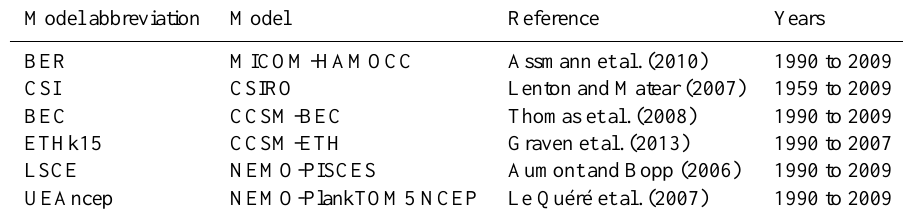
Table 2. Details of the ocean biogeochemical models included in this study.